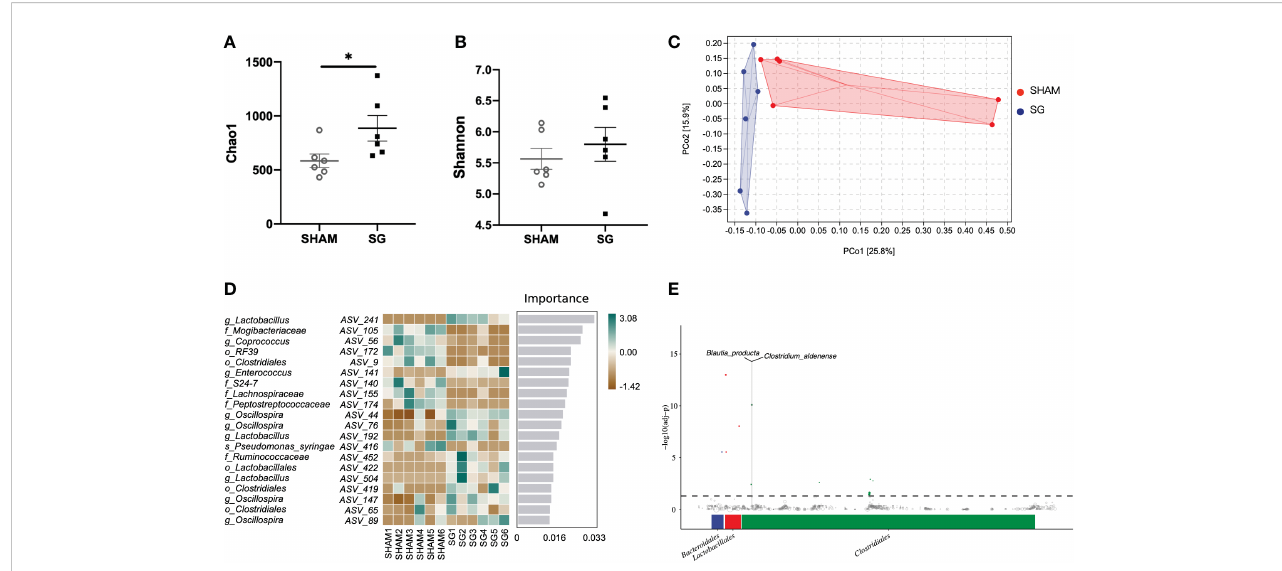
FIGURE 3 SG resulted in alterations of the gut microbiota. (A, B) . Chao1 and Shannon index of the gut microbiota in the fecal samples. Student ’ s t-test was used for signi fi cance assessments. *P < 0.05. (C) Unweighted UniFrac principle coordinates analysis (PCoA). (D) Discriminatory importance scores of top-ranked ASVs identi fi ed by the Random Forest analysis. A comparison of the relative abundance of top-ranked ASVs between SG and SHAM gut microbiota. Green and brown indicate the degree of relative abundance. (E) MetagenomeSeq analysis showing signi fi cantly enriched microbes following SG relative to SHAM operation. The X and Y axis represent taxonomic order and the -log10(adj-Pvalue) value, respectively. Dots of blue, red, and green represent abundant microbes under Bacteroidales , Lactobacillales , and Clostridiales , respectively. n = 6/group; Data are means ± SEM. SHAM, sham surgery; SG, sleeve